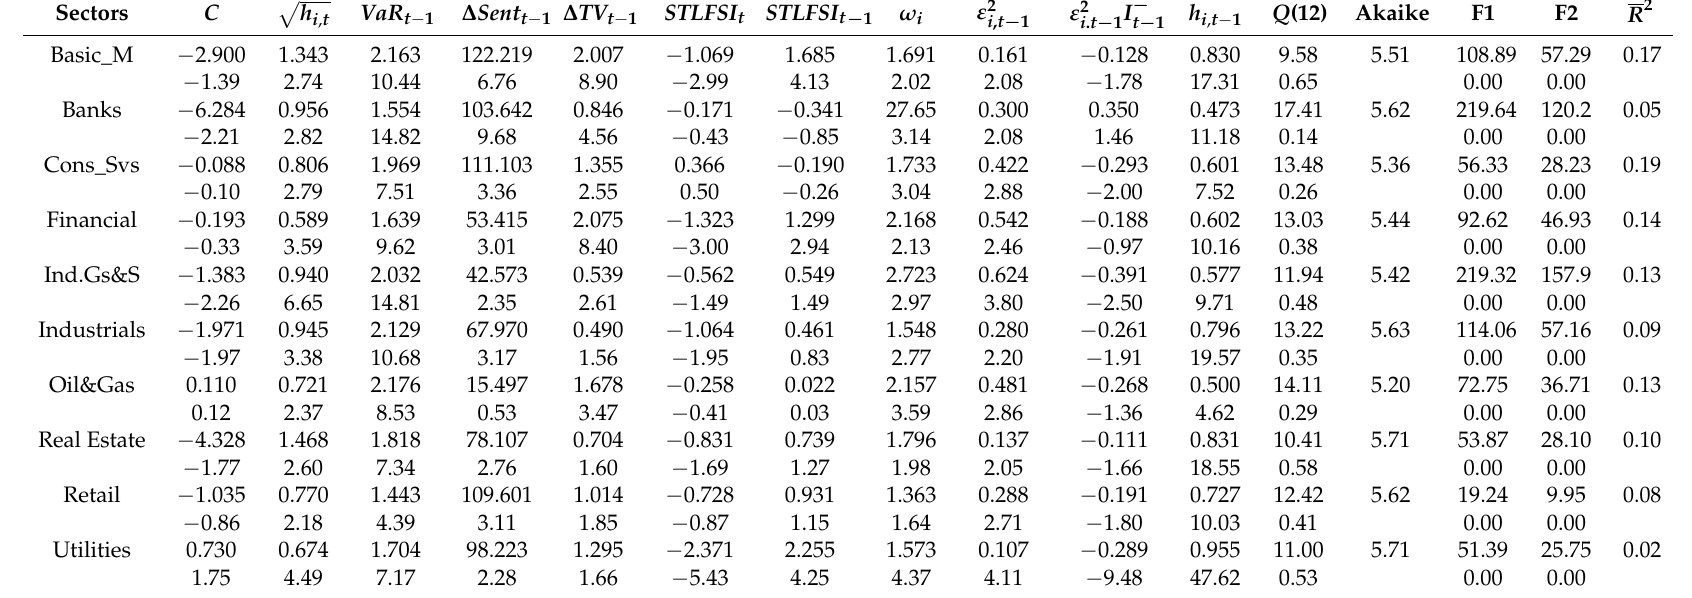
Table 5. Estimates of stock returns on downside risk, U.S. market stress, sentiment, and liquidity with a GED-TARCH-M